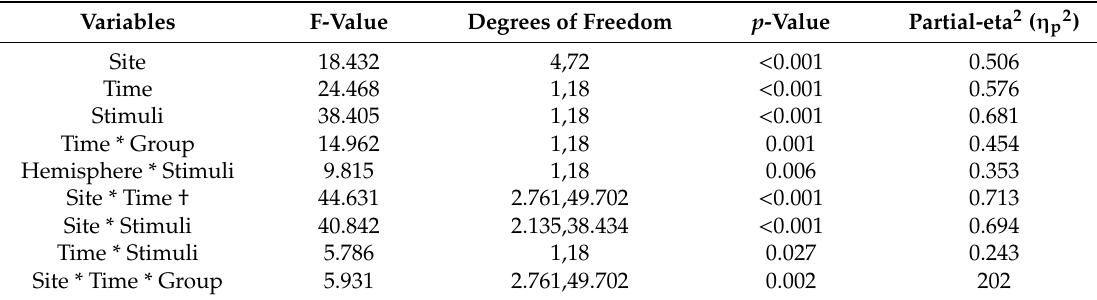
Table 2. Statistically significant ANOVA summary table for main e ff ects and interactions of site weights. Significance =< 0.05. † = Degrees of freedom corrections applied using Greenhouse–Geisser due to violations of sphericity